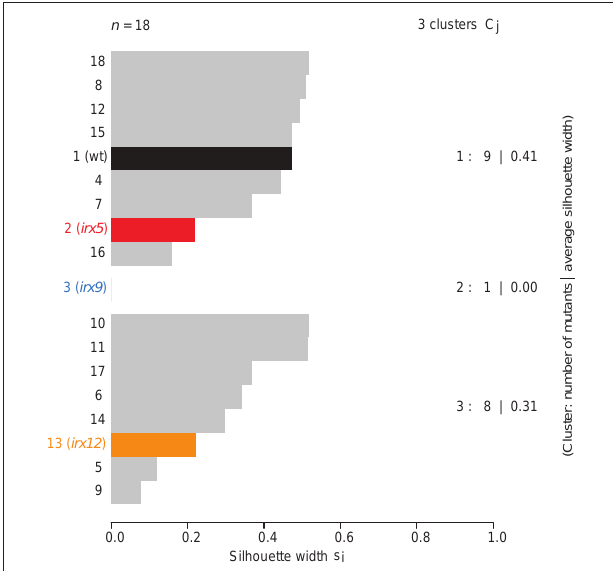
Figure 6 | Clustering of combined sugar profiles from the four different cell wall fractions. Clustering summary of mutants based on the k-mediod algorithm. The number of clusters (3) was estimated based on the silhouette width, i.e., the dissimilarity in sugar profiles as measured by the Euclidean distances between the combined profiles. Wild-type (black), and mutants affecting cellulose ( irx5 ; red), xylan ( irx9 ; blue), and potentially lignin ( irx12 ; orange) are indicated in different colors. The average silhoutte width was calculated to 0.34.